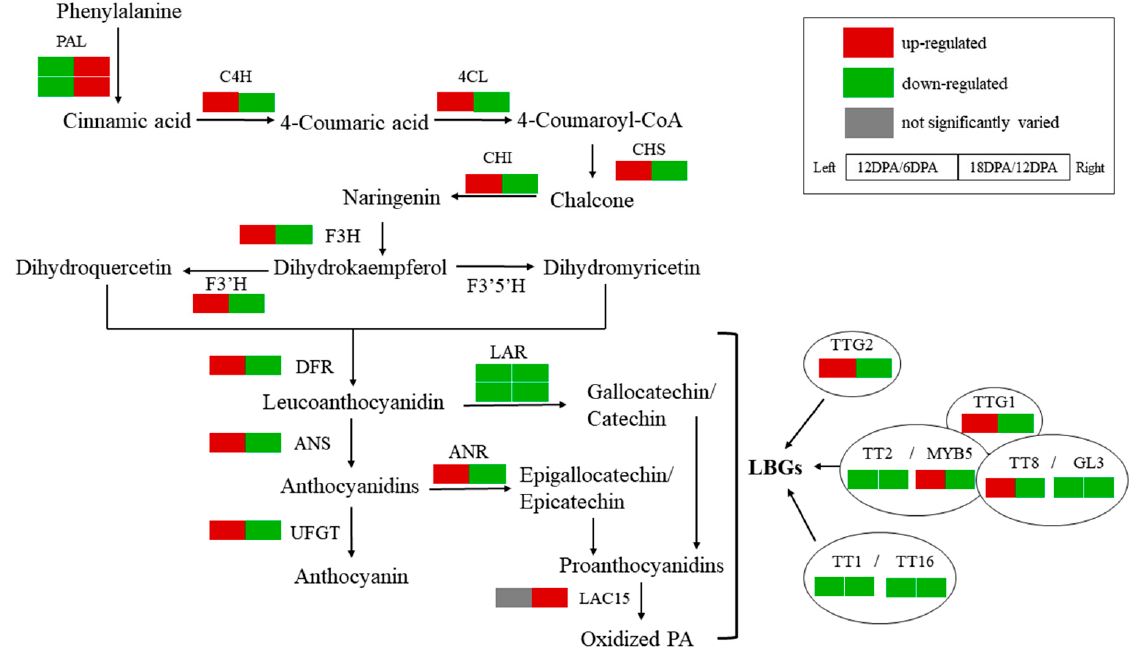
Figure 6. Differentially expressed proanthocyanidin biosynthetic genes during fiber development in Gossypium stocksii (6, 12, and 18 DPA). LBGs: late biosynthetic genes.